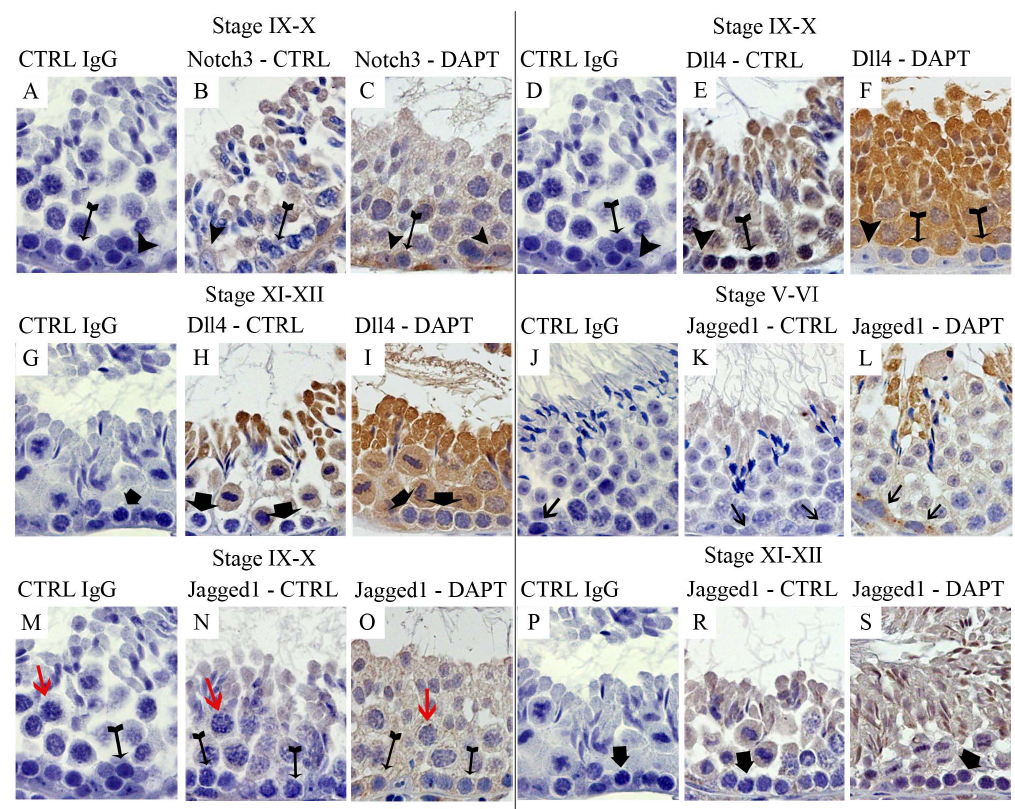
Figure 1. Disruption of expression patterns of Notch components along the spermatogenic cycle following DAPT treatment. Positive staining in brown, counterstaining with haematoxylin (400x magnification). Arrow heads point Sertoli cells. Tailed arrows point leptotene spermatocytes. Bold arrows point zygotene spermatocytes. Arrows point spermatogonia. Red arrows point pachytene spermatocytes. Control (CTRL) slides used rabbit IgG (A, D, G, J, M, P). Notch3 shows ectopic expression in Sertoli cells and in leptotene spermatocytes at stages IX–X. (B and C). Dll4 stops being expressed in leptotene spermatocytes and Sertoli cells at stage IX–X (E and F), and shows ectopic expression in zygotene spermatocytes at stage XI–XII (H and I). Jagged1 shows ectopic expression in spermatogonia at stages V–VI (K and L); in leptotene and pachytene spermatocytes at stages IX–X, (N, O); and in zygotene spermatocytes at stages XI–XII (R and S).